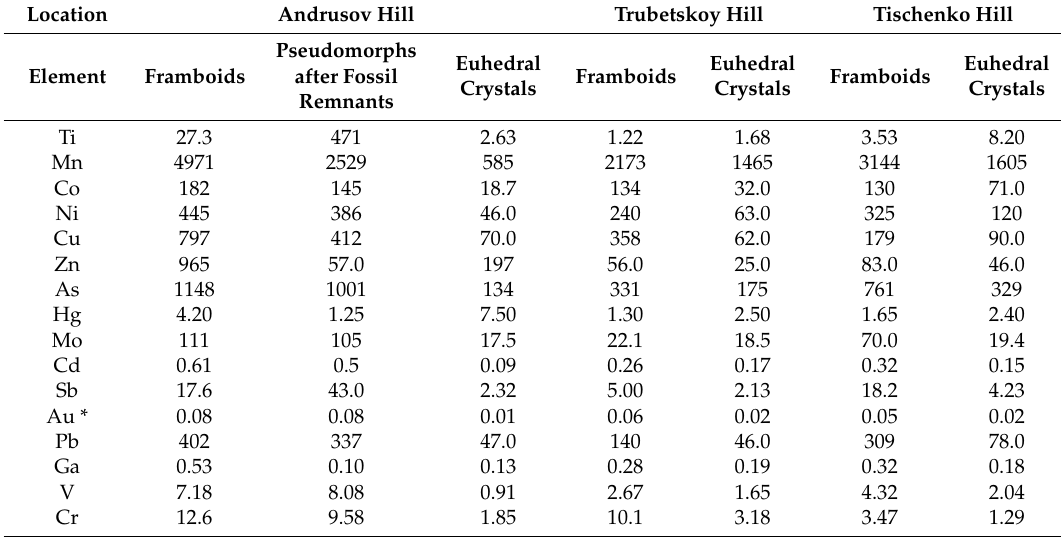
Table 6. Trace element contents in pyrite fractions from mud masses, Bulganak MV area, Kerch-Taman MV province. ICP-MS data, ppm.